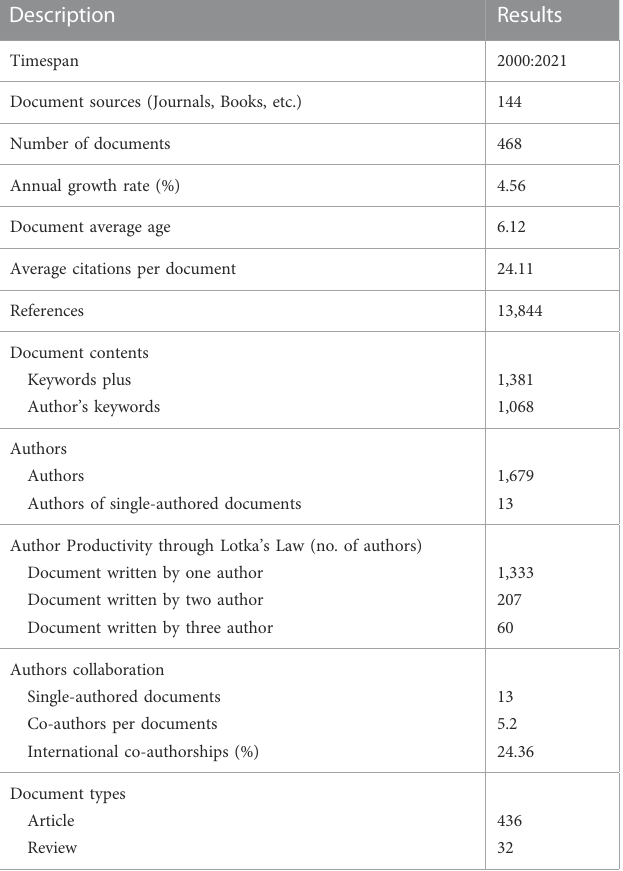
TABLE 1 Main characteristics of the published articles on heat stress and poultry.